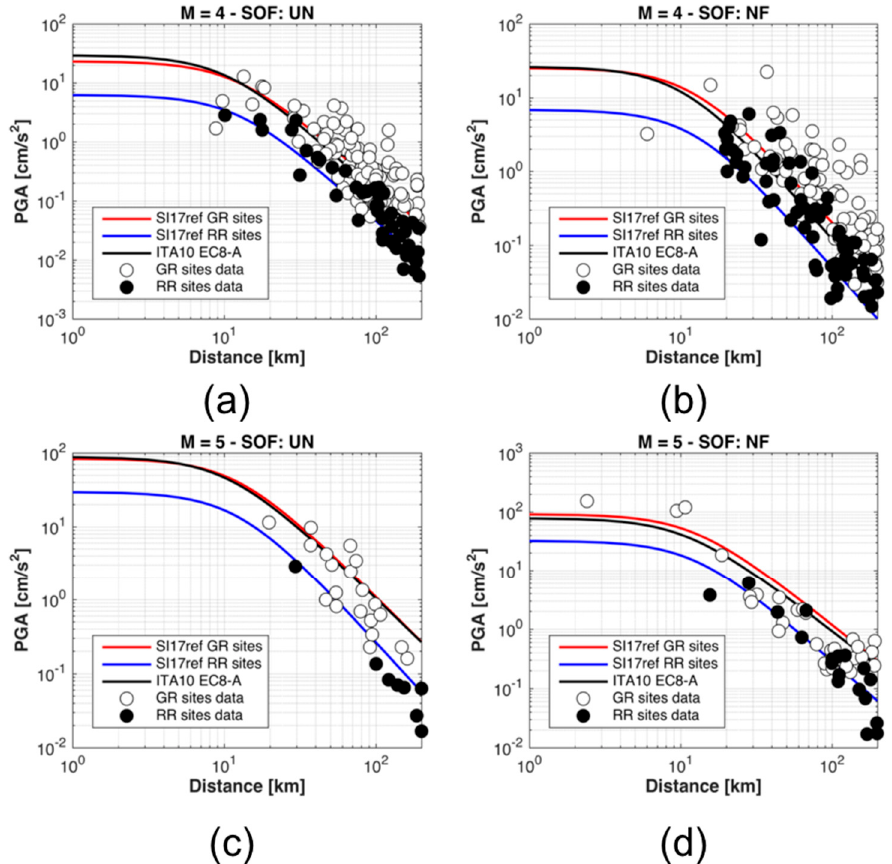
Figure 15. SI17ref attenuations with distance for magnitude M = 4.0 with normal faulting (NF) ( a ); magnitude M = 4.0 with undefined faulting (UN) ( b ); magnitude M = 5.0 with normal faulting (NF) ( c ); and magnitude M = 5.0 with undefined faulting (UN) ( d ). Black circles, empirical data points of the RR sites; white circles, empirical data points of the GR sites.